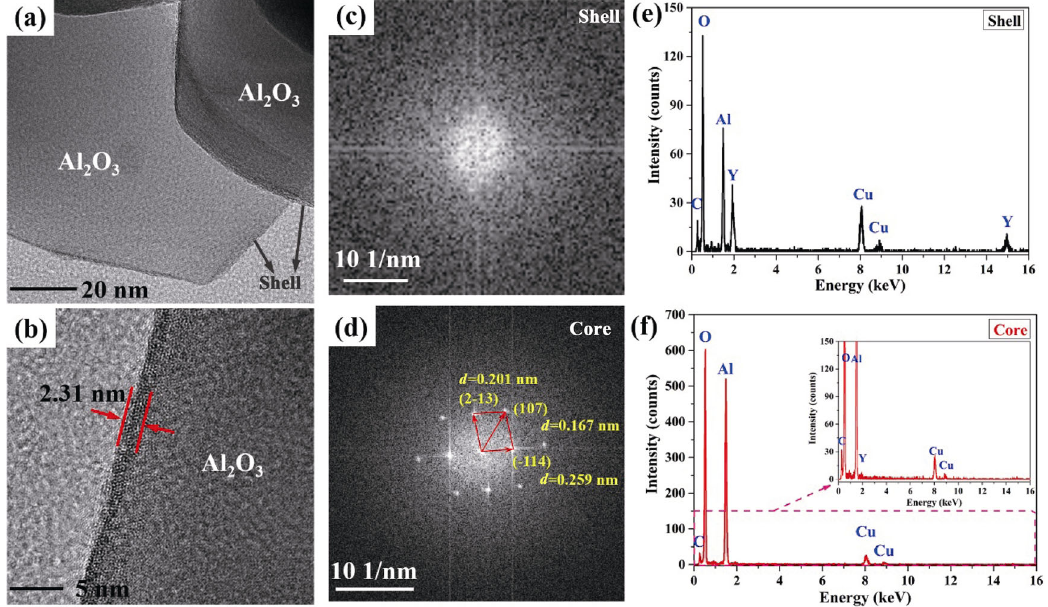
Fig. 2 (a) Representative TEM image of the CP processed Y 2 O 3 –Al 2 O 3 ceramic powder, (b) high magnification TEM image representing the surface of the CP processed powder, (c, d) the corresponding fast Fourier transform patterns of the shell and core, and (e, f) respective EDS spectra recorded from the shell and core.